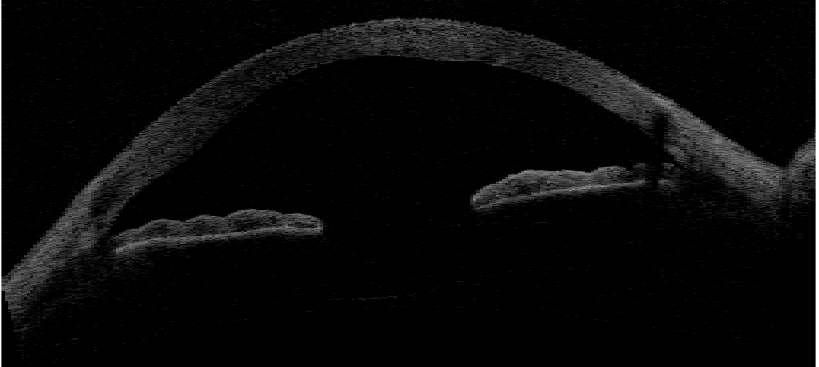
Figure 2. Time-domain (TD) optical coherence tomography (OCT) imaging of the anterior segment. Although the TD-OCT platform was commercialized as the first OCT system specifically conceived for anterior segment imaging (Visante OCT), it clearly provides an inadequate resolution to analyze in detail the fine changes in the tear dynamics and ocular surface epithelia. However, an interesting feature of TD systems may be represented by the wide field of view (scan depth and width) of the ocular surface profile and anterior segment